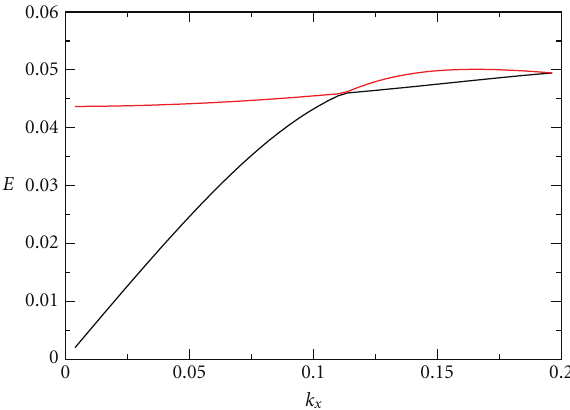
Figure 6: The lowest-lying modes for V = 4 . 3 and U = 18. The system is very close to a ground state transition. Note the almost gapless Q